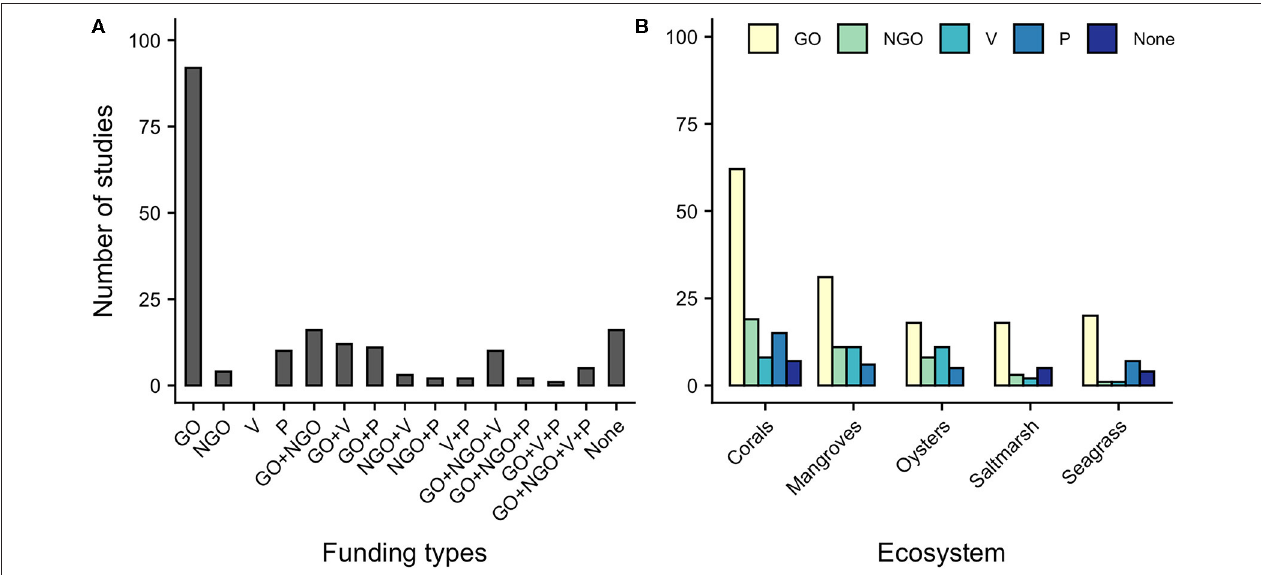
FIGURE 6 | Type of financial contributors to marine coastal restoration projects extracted from the acknowledgments of each primary study. (A) Shows the combination of funders across all studies ( n = 186). (B) Shows the number of studies by ecosystem that had support from each funding type (note: a single study can be represented in multiple bars if it received funding from multiple sources). Abbreviations: GO, governmental; NGO, non-governmental; V, supported by volunteers; P, supported by private organizations or businesses, and None, no funding